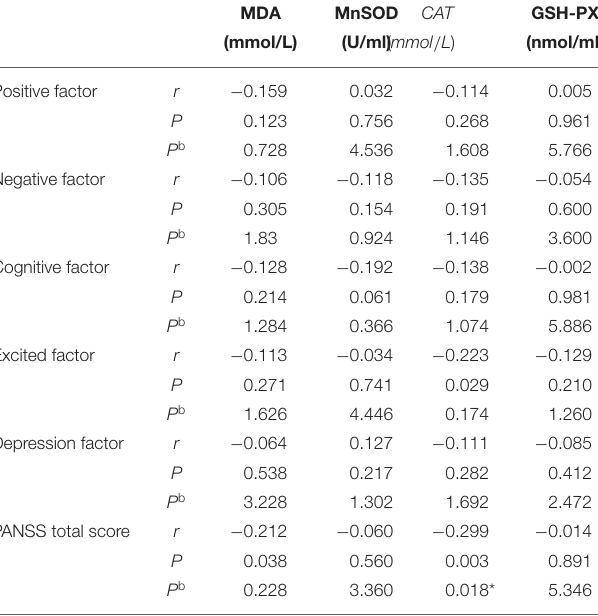
TABLE 4 | Relationships between oxidative stress markers and psychotic symptom in patients a